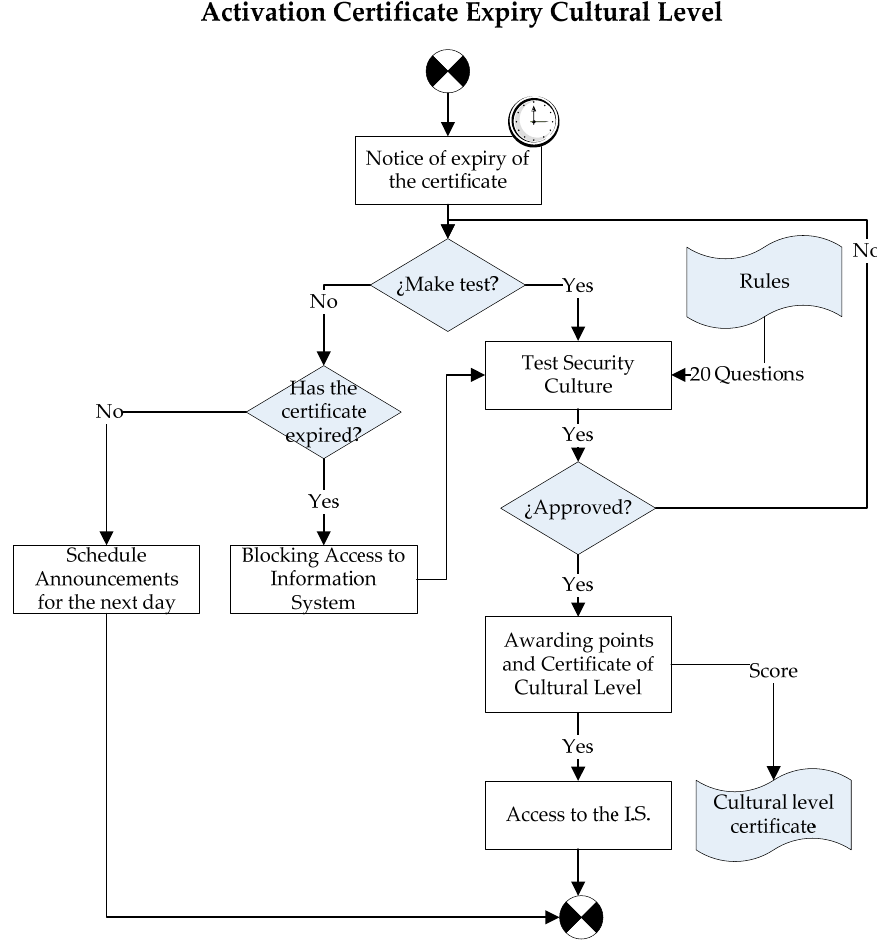
Figure 6. Schema for SC certificate renewal.